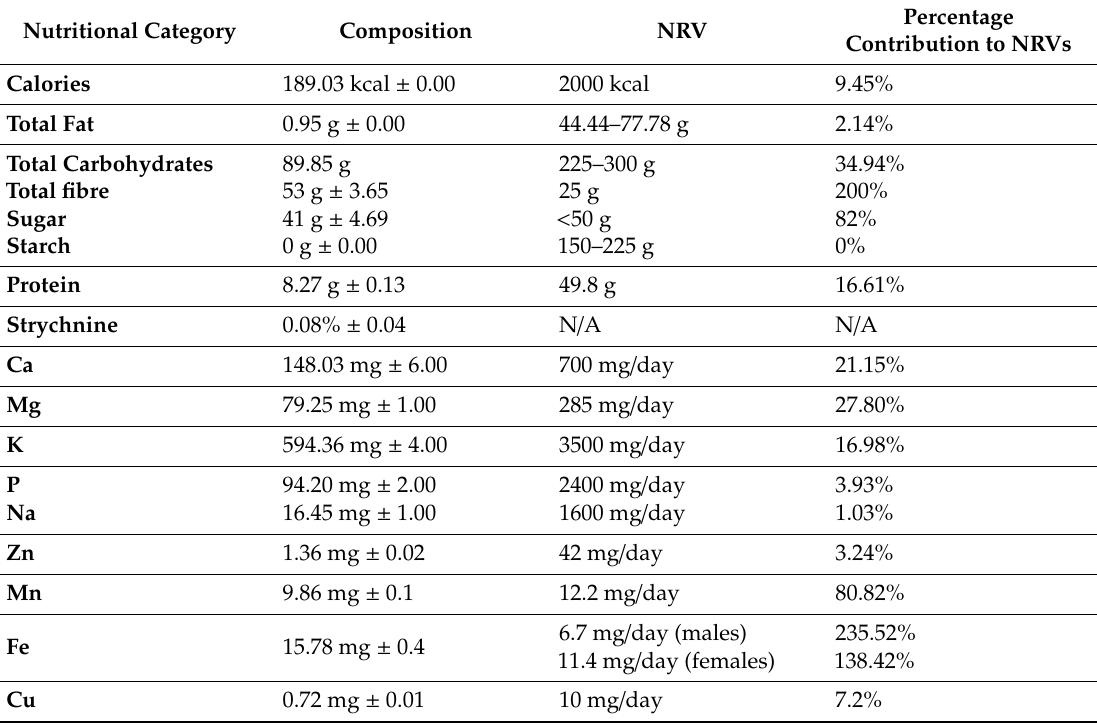
Table 1. Nutritional composition and strychnine content of S. madagascariensis seed flour (per 100 g) and the flours’ percentage contribution to